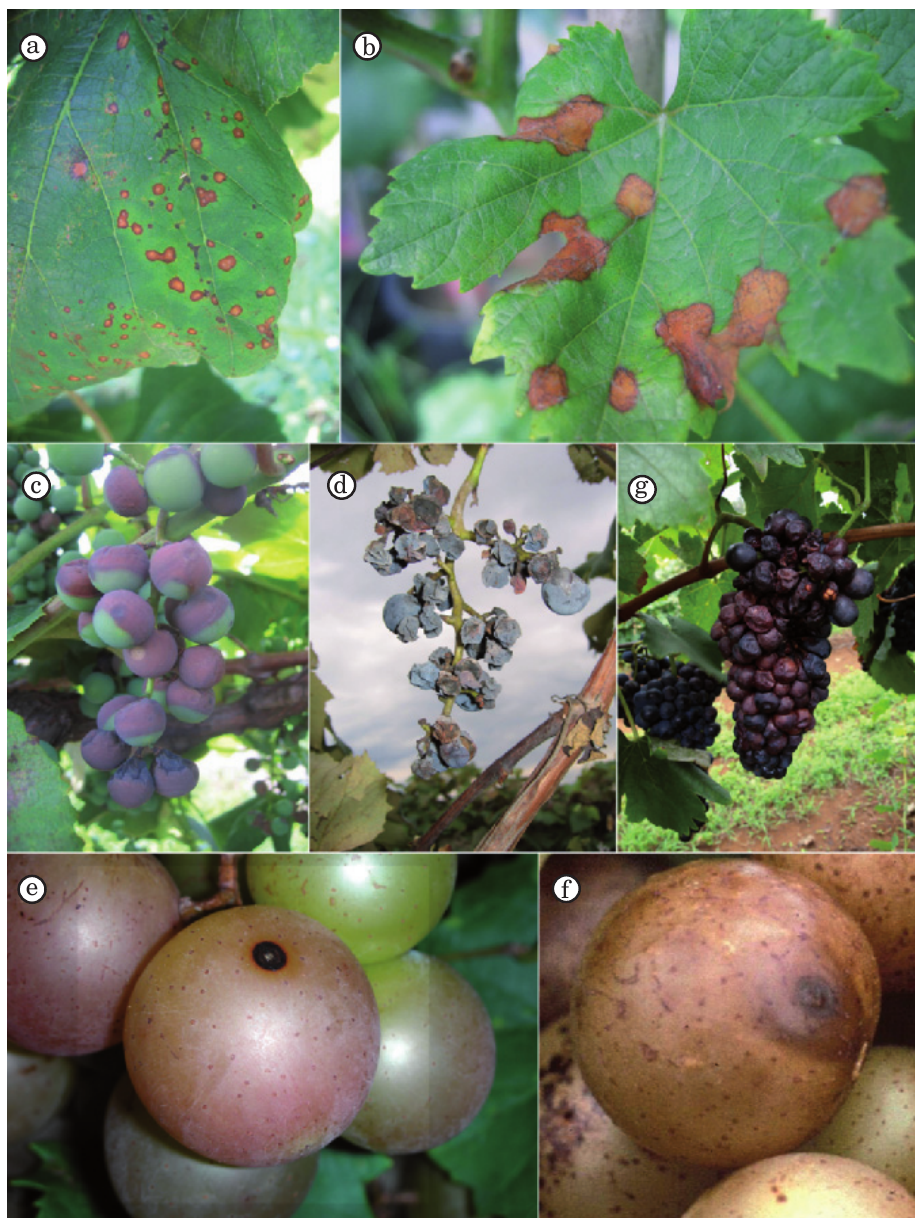
Figure 1. a–d. Black rot. a. Infections caused by Guignardia bidwellii on leaves start as small circular lesions. b. As infection progresses lesions expand and pycnidia develop in the center of the lesions. c. Infection of the fruit first ap- pears light in color. d. As fruit infection progresses, berries turn dark in color and eventually shrivel becoming rais- ing-like body masses named “mummies” and covered with pycnidia. (Pictures courtesy of Dr. M. Sosnowski, South Australian Research and Development Institute, Adelaide, Australia). e–f. Macrophoma rot. e. Infections caused by Botryosphaera dothidea first appear as single flat or slighted sunken dark areas. f. As disease progresses, a brown soft rot covers the berry spreading through the whole cluster. (Pictures courtesy of Dr. T.B. Sutton, Department of Plant Pathology, North Carolina State University, Raleigh, North Carolina, USA). g. Bunch rot associated with Botryosphaeriaceae spp. on Shiraz in southeastern Australia (Picture courtesy of N. Wunderlich, Charles Sturt Uni- versity, Wagga Wagga,